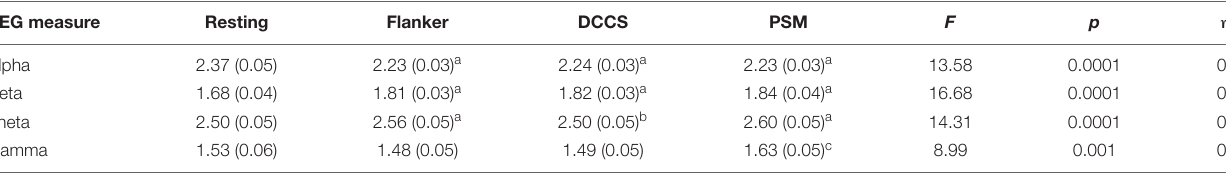
TABLE 1 | Descriptive statistics for EEG PSD and summary of ANOVA results and post hoc testing.